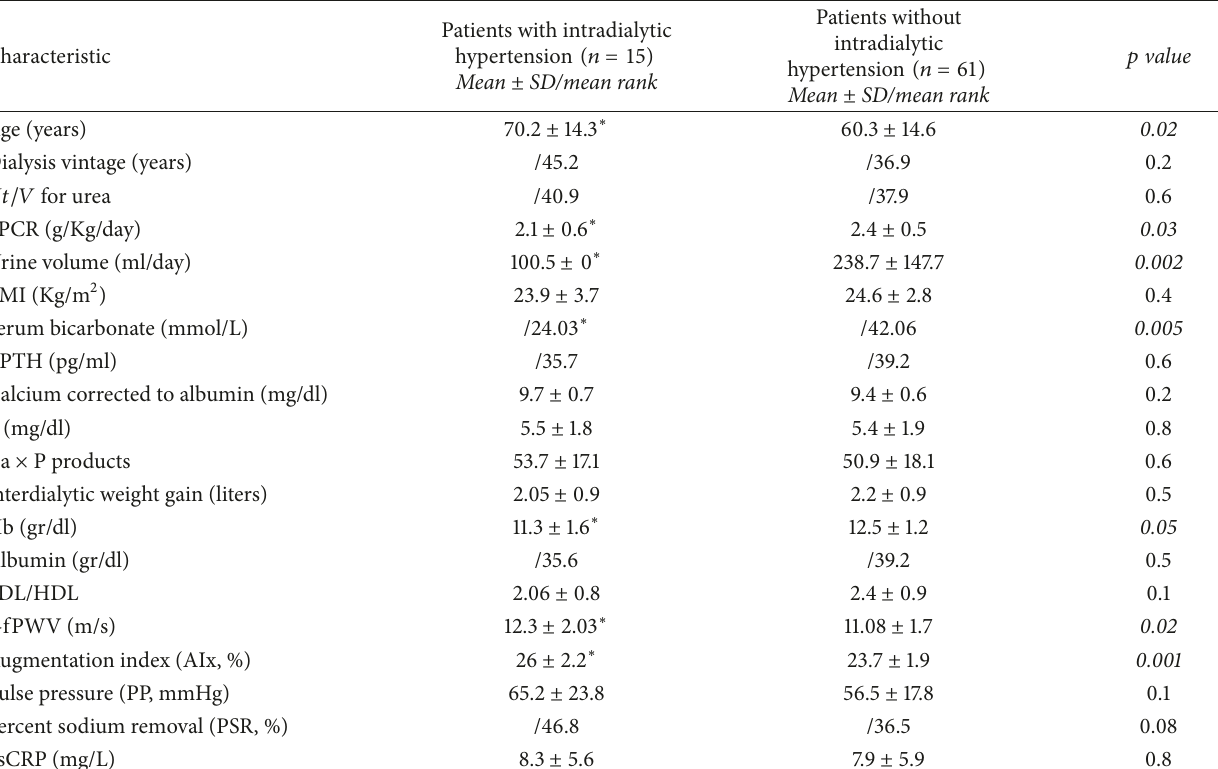
Table 1: Differences between groups of patients according to the manifestation of intradialytic hypertension in a total of 76 subjects in hemodiafiltration ( ∗ 𝑝 ≤ 0.05 ).